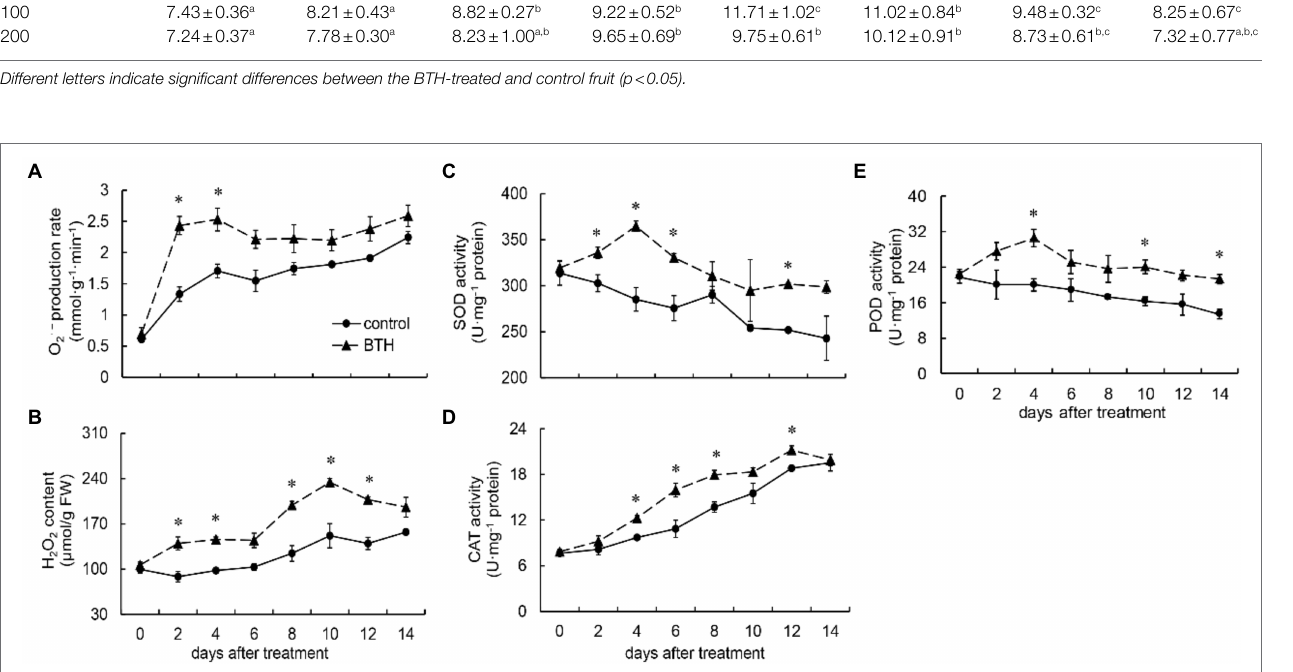
FIGURE 2 | Changes in superoxide anion (O 2• − ) production rate (A) , hydrogen peroxide (H 2 O 2 ) content (B) , and the activities of superoxide dismutase (SOD; C ), catalase (CAT; D ), and peroxidase (POD; E ) in R. roxburghii fruit after BTH treatment during low temperature storage. The significant differences at a level of 0.05 by LSD between the control and BTH-treated fruit are indicated by asterisks (*). Vertical bars represent the standard errors of the means